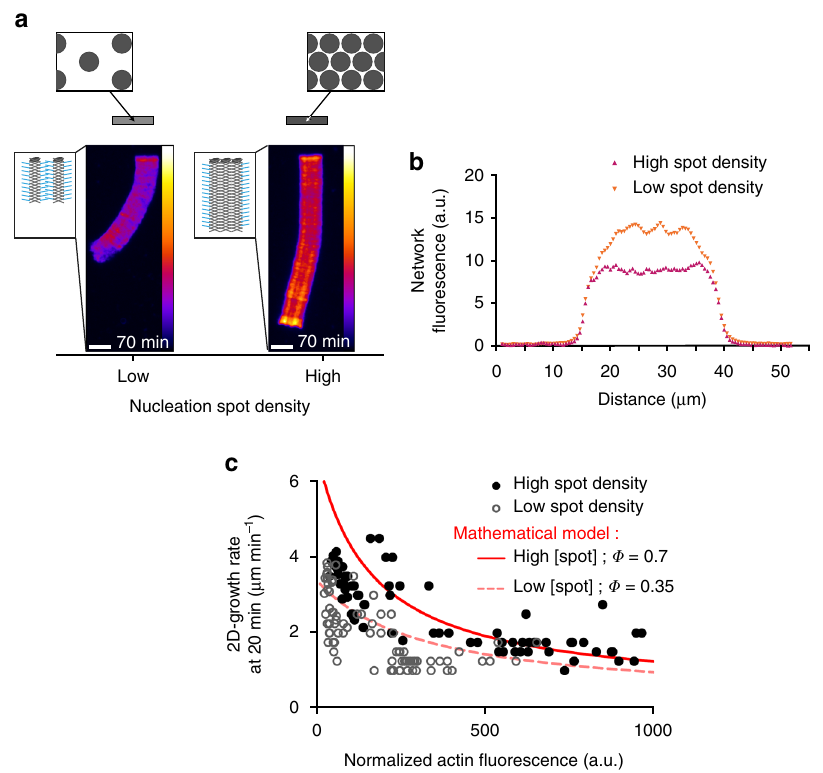
Fig. 5 Actin fi lament organization modulates the growth of the network. a Images of typical LMs of variable NPF-spot density on bar-shaped pattern. The images taken after 70 min of actin assembly reveal that in contrast to Fig. 4, sparser networks grew slower than the denser ones. b The network density was measured across the LMs (along the white line as indicated in Fig. 4a, left image). c Network growth rates at 20 mn were represented as a function of the network fl uorescence. Experimental data are represented by the symbols (high spots density, closed circles ; low spots density, opened circles ). Simulated growth rates at 20 min ( red and dashed solid lines ) were calculated as a function of computed fi lament densities according to a 2-fold degrease in Φ between the high- and low-spot density patterns. Scale bars are 15 µ m (see also related Supplementary Fig.